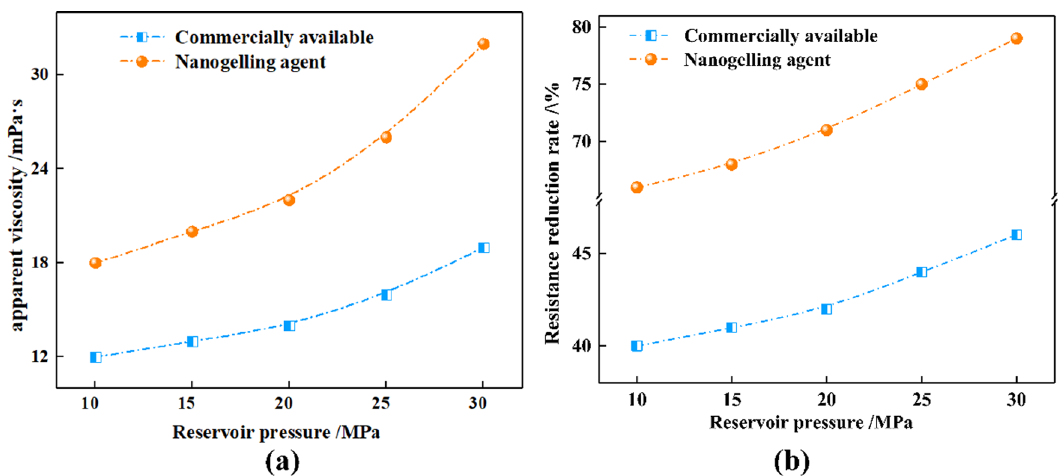
Figure 6: Variation in apparent viscosity and drag reduction rate of acid solution with reservoir pressure for di ff erent gelling agents: ( a ) E ff ect of reservoir pressure on fl uid viscosity; ( b ) e ff ect of reservoir pressure on resistance reduction rate.